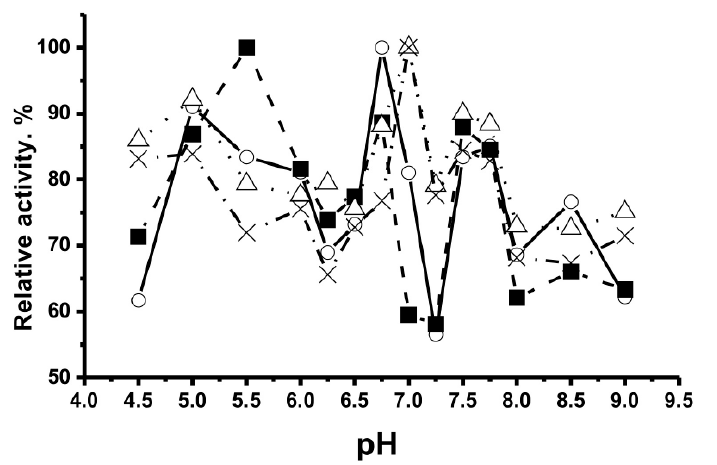
Figure 6. Dependences of the relative peroxidase activity of four Wistar rats IgGs ( ∆ , □ , ×, and o) on pH of reaction mixture The error in the initial rate determinations from three experiments in each case did not exceed 7–10% [174]. case did not exceed 7–10%